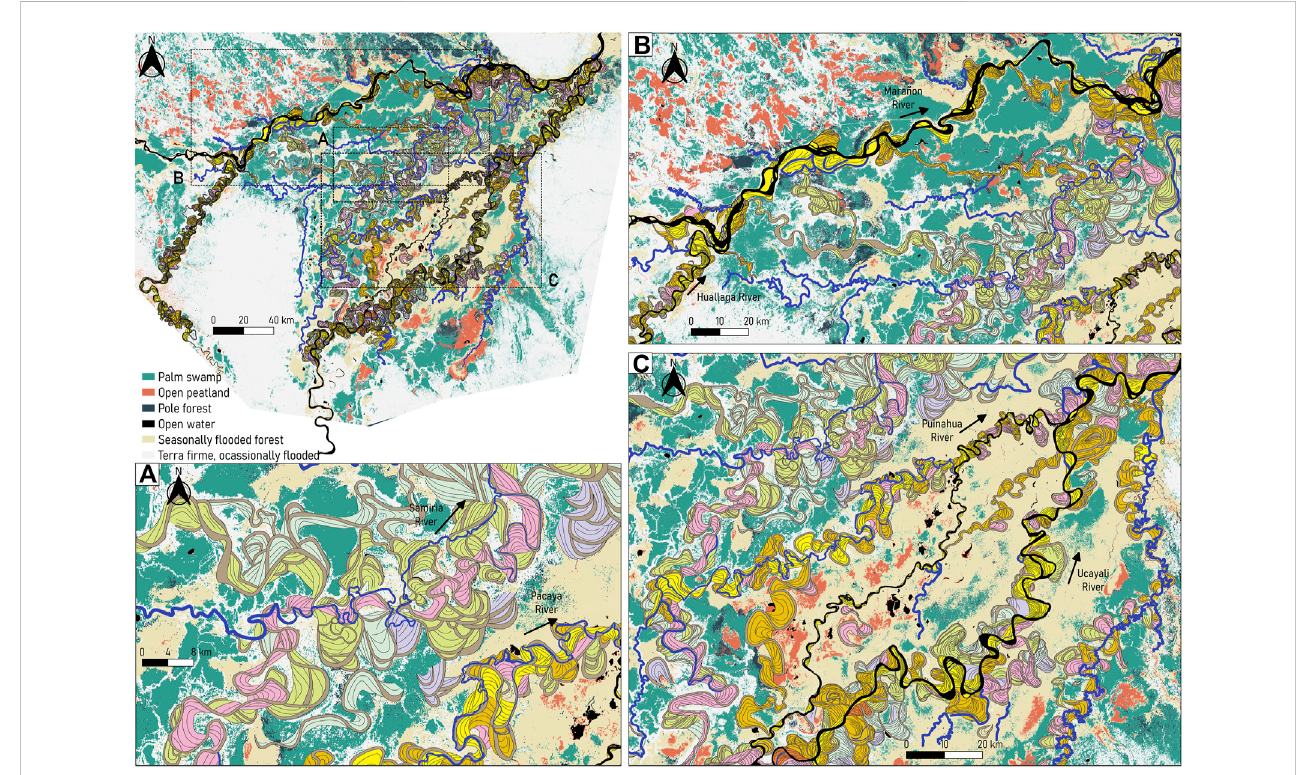
FIGURE 10 Modern and ancientriver dynamics superposed to thevegetationcover mapdevelopedby Draper etal. (2014). (A) Section within thePSNR,showingthe vegetation mosaicbetweentheSamiriaandPacayaRivers. (B) SectionalongtheMarañonRiversurroundedbylarger areasofpalmswamps. (C) Sectionofthe Ucayali River, covered by seasonally fl ooded forests and several areas of open peatlands. Land cover data provided by Draper et al.